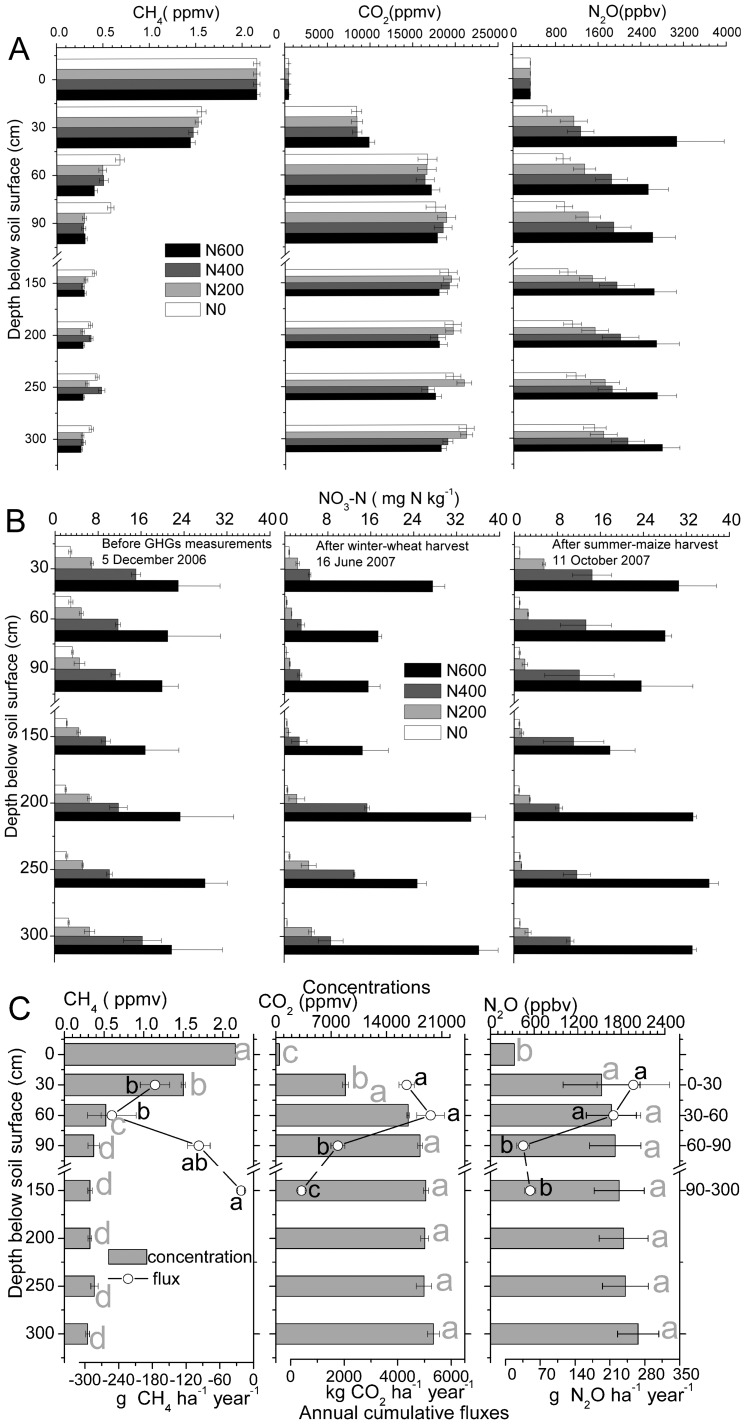
CH4, CO2 and N2O concentrations (mean ± standard deviations, n = 3) in soil air at various soil depths in a winter wheat–summer maize double cropping rotation receiving 0, 200, 400 and 600 kg of N ha−1 year−1, in 2007–2008 (A); NO3-N contents (mean ± standard deviations, n = 3) at various soil depths as function of N fertilizer application rate, in 2007–2008 (B); Profiles of concentration and annual cumulative flux of CH4, CO2 and N2O, in 2007–2008 (mean ± standard deviations, n = 4).Same letters next to the bars indicated no significant differences between slope positions (P<0.05). (C). Note the differences in X-axes.